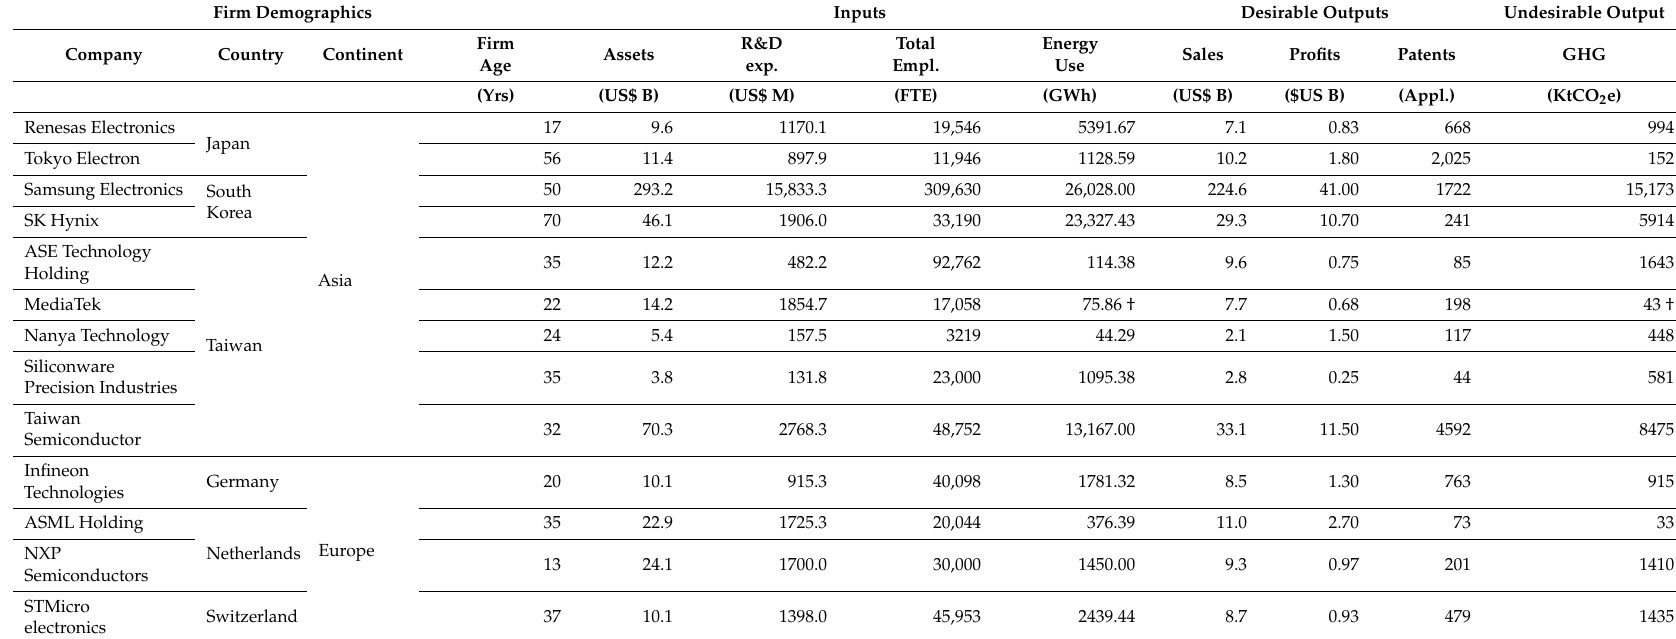
Table 4. Data and descriptive